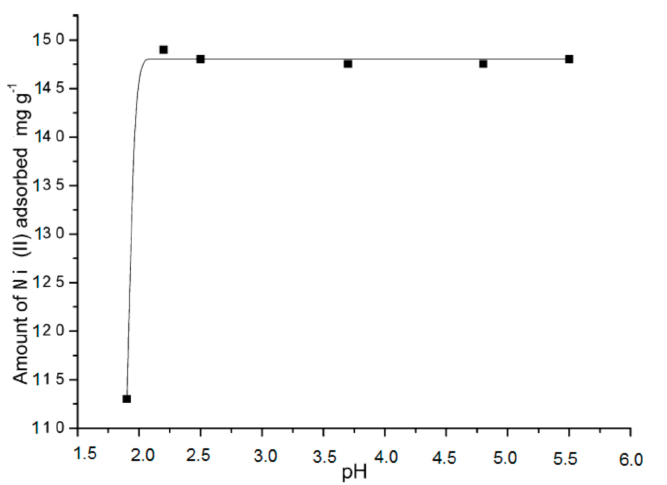
Figure 10. Effect of pH on Ni (II) adsorption on the studied carbon/30 min treatment time, 100 mg carbon adsorbent per 100 mL, 5 mg g − 1 Ni